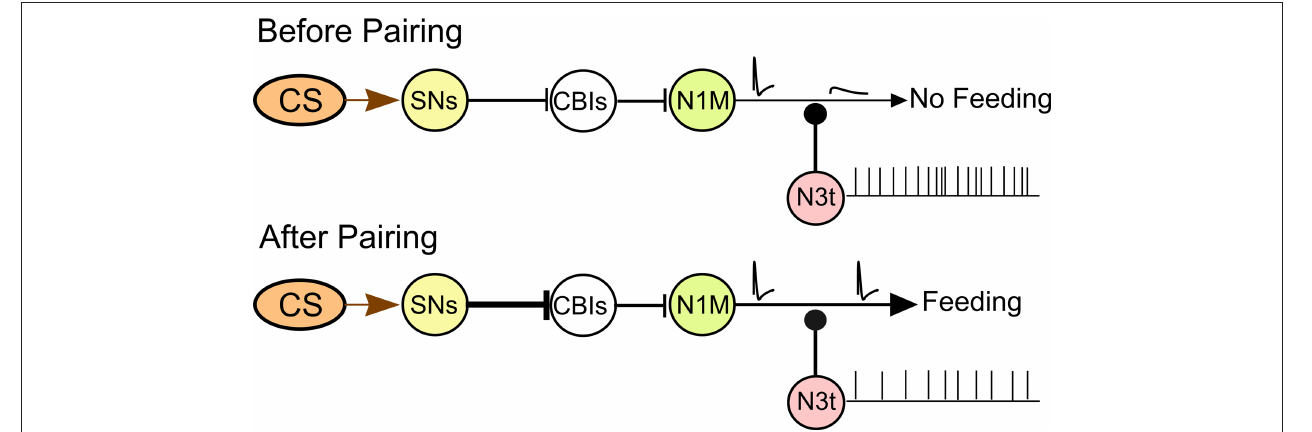
feeding response. A strengthening of the excitatory pathway is proposed between the CS sensory pathway and the CBIs. Conditioning reduces N3t inhibition of the N1M bringing it closer to the threshold potential for firing with full sized spikes present in the N1M distal axon (see text for further